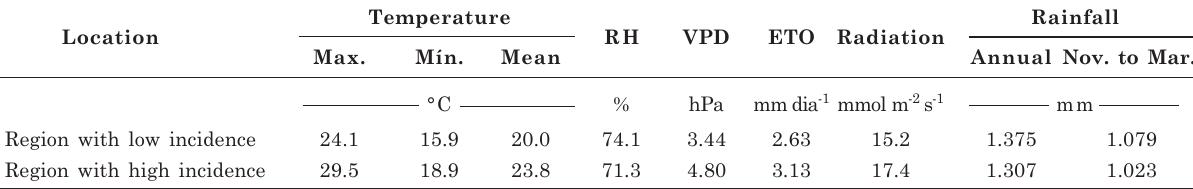
RH: relative humidity; VPD: vapor pressure deficit; ETO: evapotranspiration.